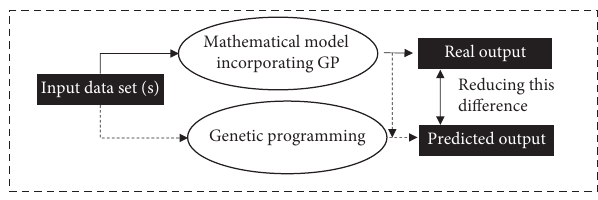
Figure 1: Simple working schematics for gene expression